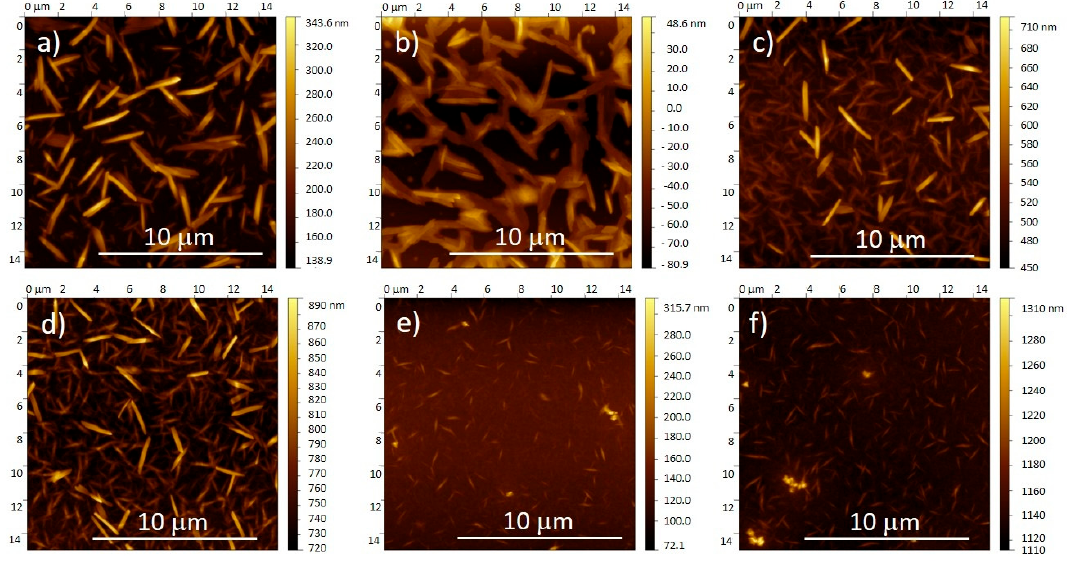
Figure 3. Atomic force microscopy (AFM) height images of PBTTT-C 14 :PDI8-CN 2 BHJ films deposited at 3000 rpm and solution temperatures of ( a ) 80 °C, ( b ) 100 °C, ( c ) 120 °C, ( d ) 140 °C, ( e ) 160 °C, ( f ) 180 °C.